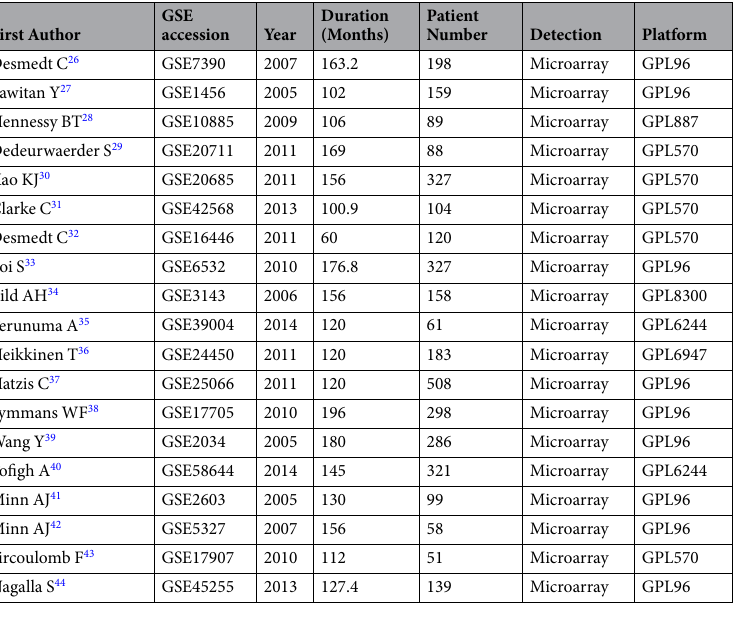
Table 1. Characteristics of the included public microarray datasets in the